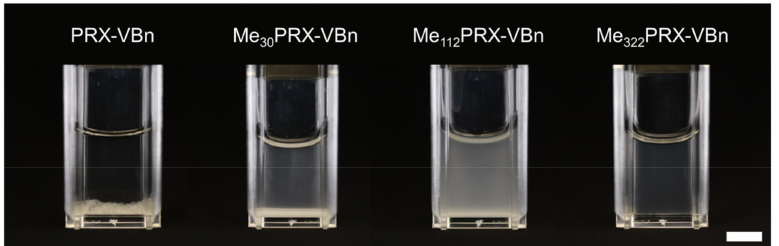
Figure 2. Photograph of polyrotaxane with 4-vinylbenzyl groups (PRX-VBn) and methylated PRX- VBn (MePRX-VBn) in water at 10 mg/mL (scale bar: 5 mm). MePRX-VBns with different degrees of methylation are abbreviated as Me X PRX-VBn, where X depicts the number of methyl